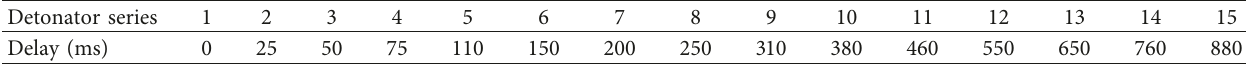
Figure 3: Typical blasting scheme for full-face excavation. Table 1: Delays with different detonator series.